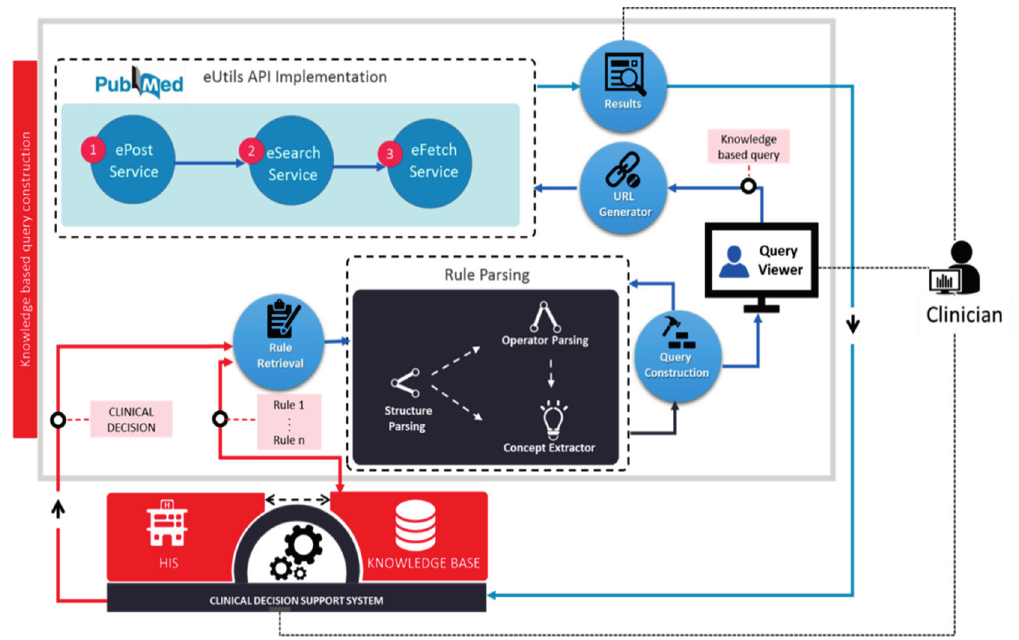
Figure 3. Knowledge-based query construction using CDSS